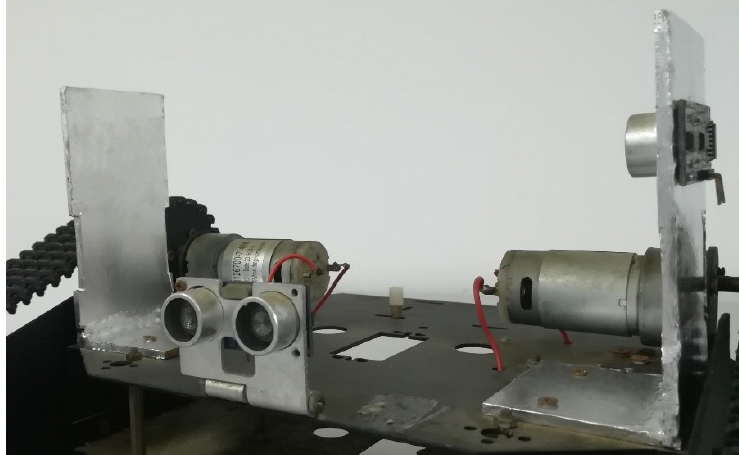
Figure 5. The Photograph of the proposed guided vehicle.